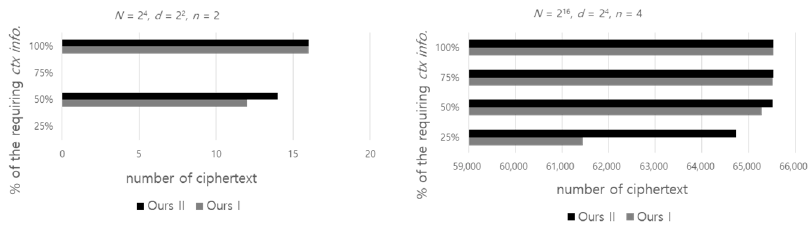
Figure 1. Simple implementation results of our order-revealing encryption for exponentially-sized domains (OREncL) schemes.